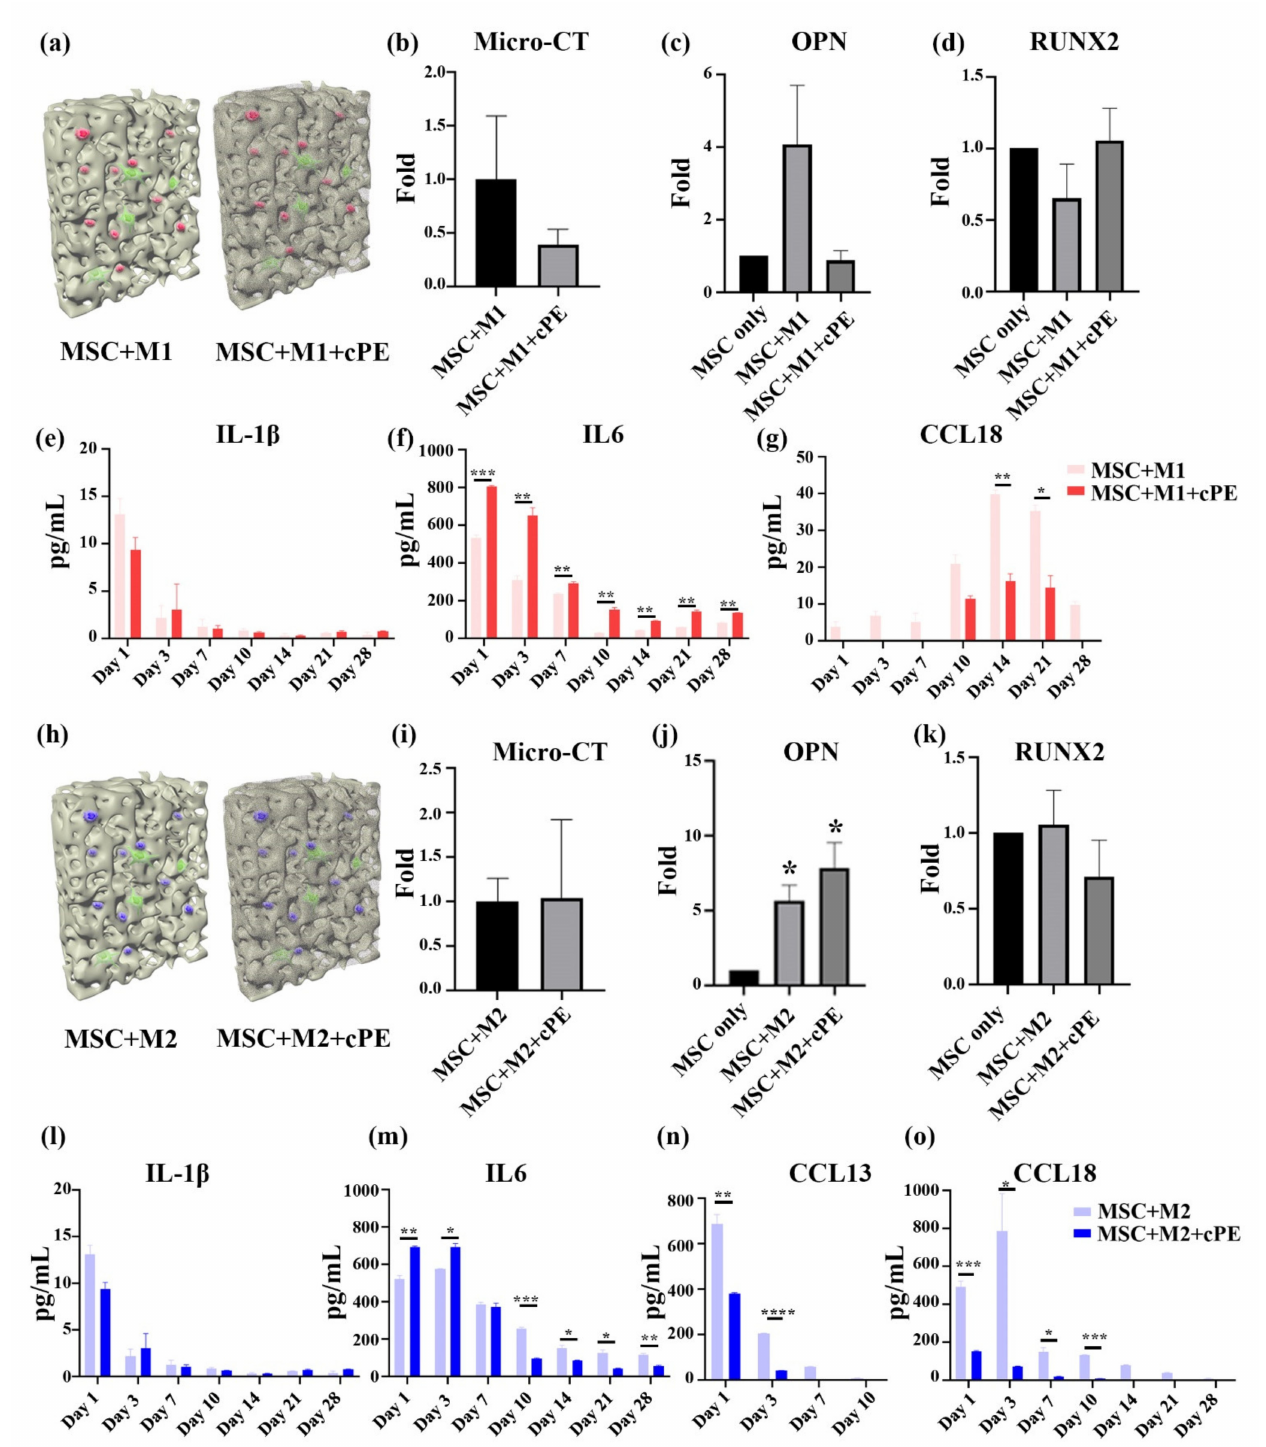
Figure 4. Effects of macrophage polarization on MSC osteogenesis after 4 weeks of co-culture in 3D scaffolds. ( a – g ) M1 co-cultures. ( a ) Cross-sectional illustration of the M1 macrophage–MSCs co-culture. ( b ) Mineralization of the tissue quantified by micro-CT. ( c , d ) Osteogenic gene expression analyzed by qPCR. ( e – g ) Cytokine secretion profiles of IL-1 β , IL6, and CCL18 analyzed by ELISA. ( h – o ) M2 co-cultures. ( h ) Cross-scheme illustration of the M2 Macrophage–MSCs co-culture. ( i ) Mineralization of the tissue quantified by micro-CT. ( i – k ) Osteogenic gene expression analyzed by qPCR. ( l – o ) Cytokine secretion profiles of IL-1 β , IL6, CCL13, and CCL18 analyzed by ELISA. (* p < 0.05, ** p < 0.01, *** p < 0.001, **** p <